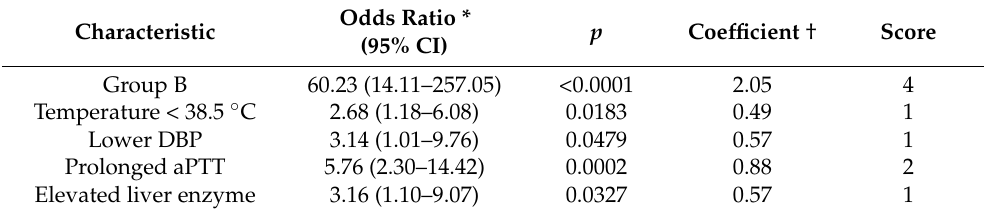
Table 3. Indicators for predicting critical outcomes in dengue patients in backward stepwise regression.